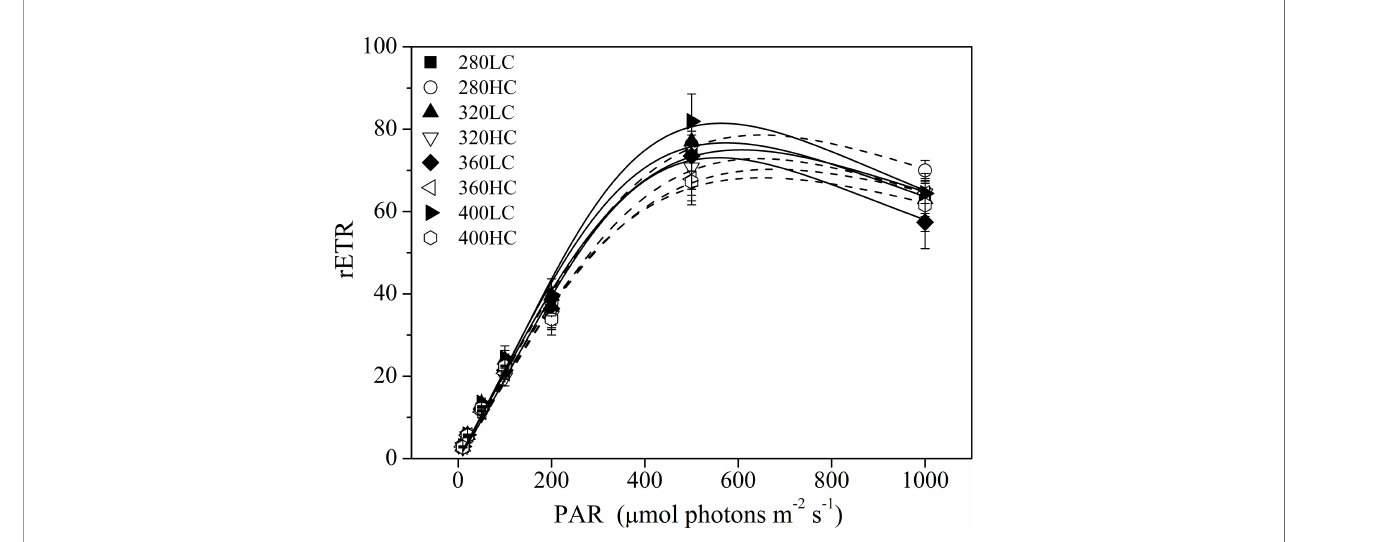
FIGURE 7 | The RLCs of S. costatum acclimated to ambient (LC, black bars) and elevated CO 2 (HC, white bars) in different spectral